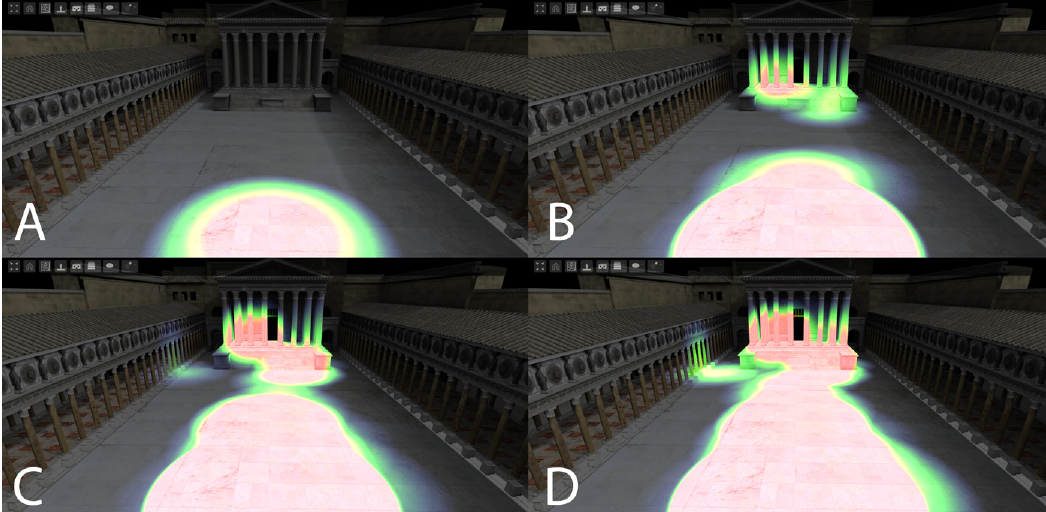
Figure 8. Progressively decoding σ p (location persistence over time) from A to D on the GPU at